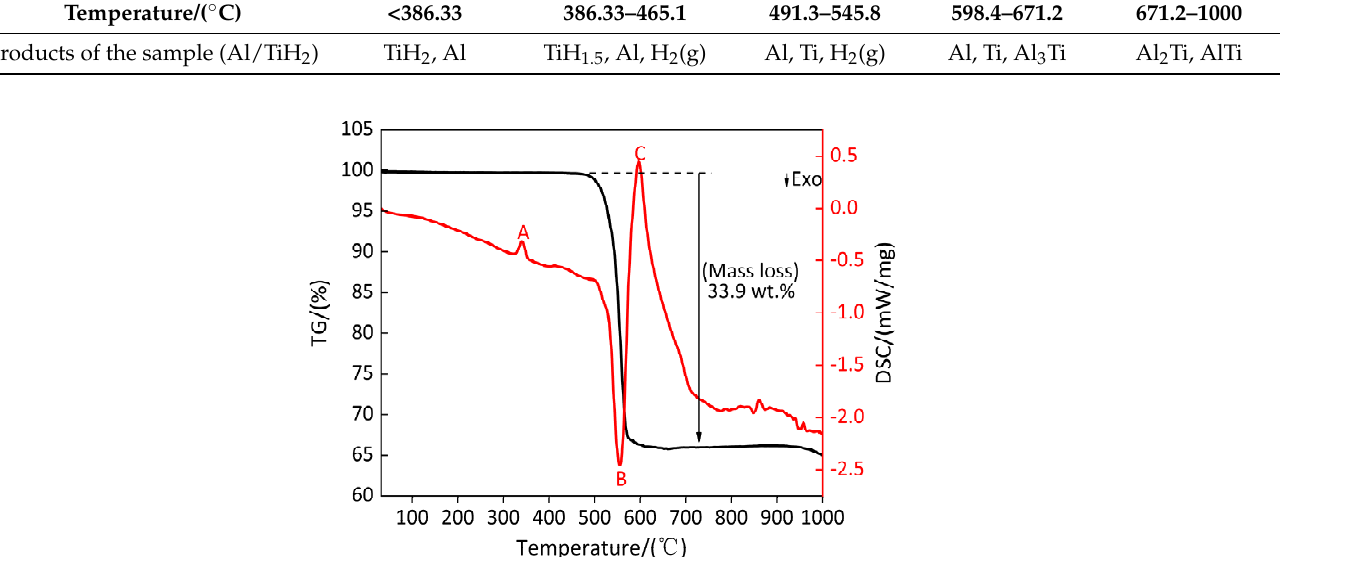
Figure 15. XRD patterns of the sample (Al/TiH 2 ) at peak temperature and 1000 °C. ( a ) XRD pattern at 444.7 °C; ( b ) XRD pattern at 523.9 °C; ( c ) XRD pattern at 633.8 °C; ( d ) XRD pattern at 1000 °C. Table 14. Products of samples (Al/TiH 2 ) at different temperatures.